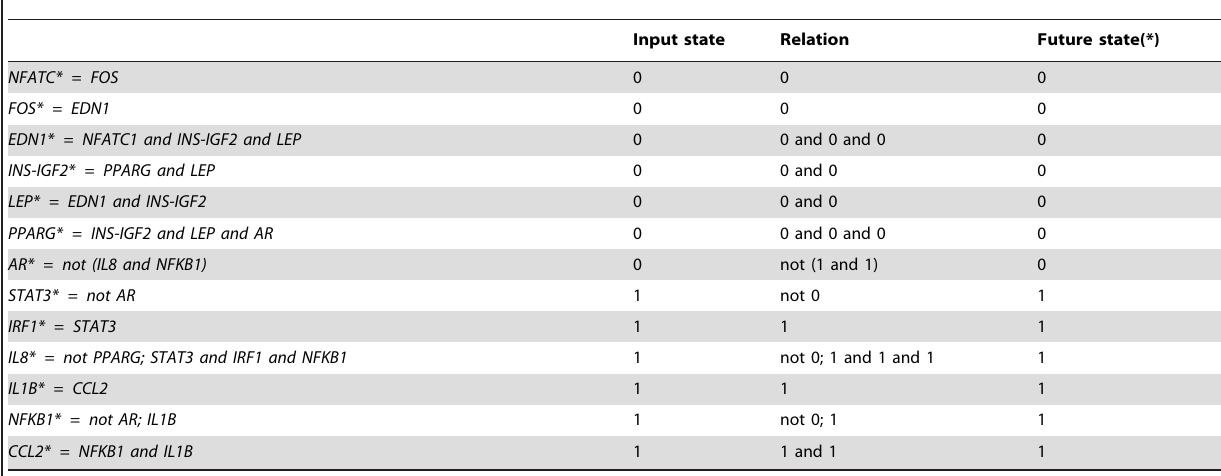
Table 6. Boolean analysis of controller